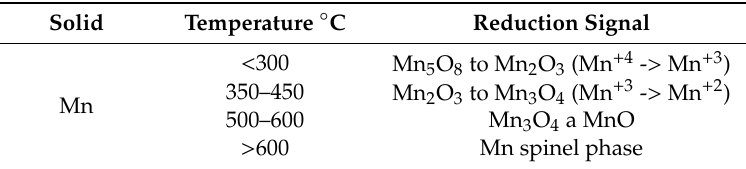
Table 5. Temperature range for reduction peaks in